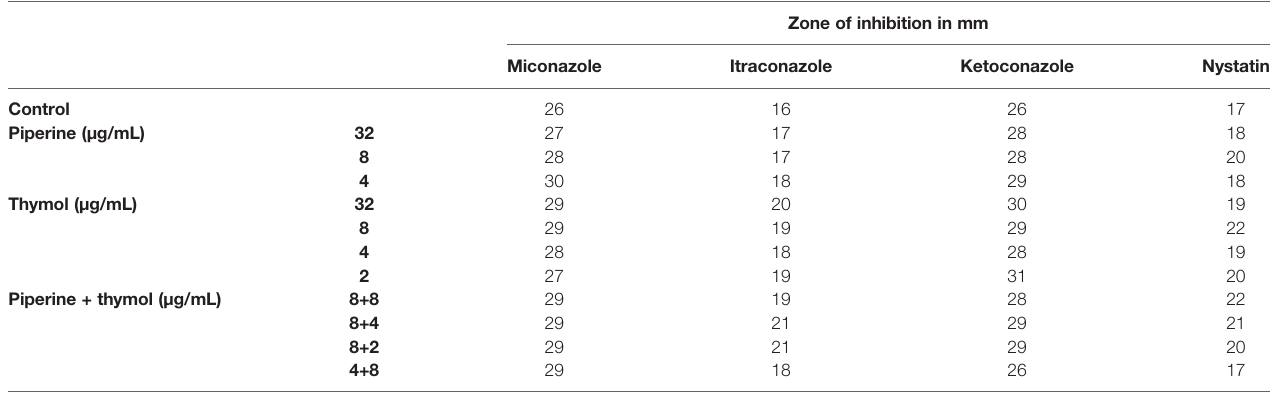
TABLE 3 | Susceptibility of C. albicans to antifungals in the absence and presence of individual and synergistic combinations of piperine and